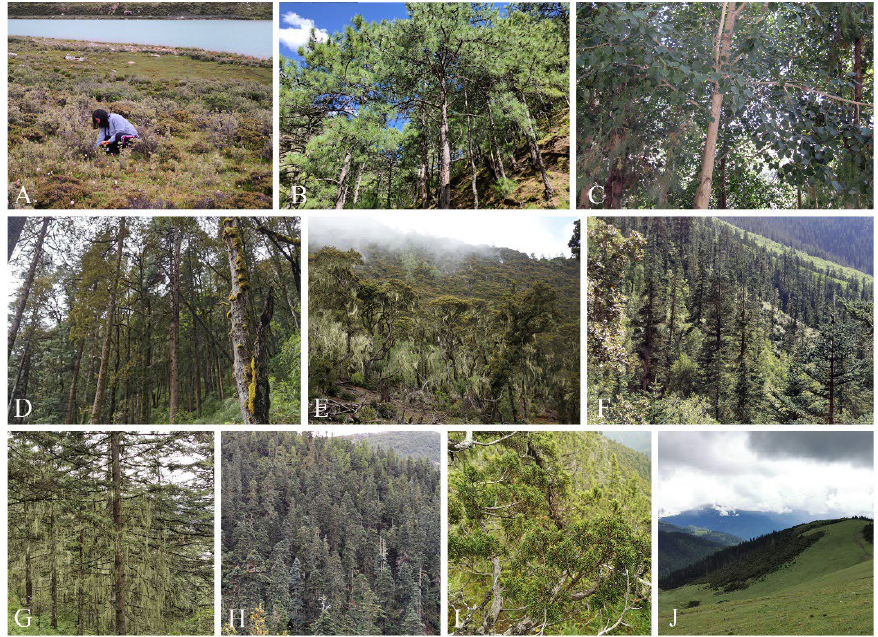
Figure 1. Vegetation types in the Shaluli Mountains. ( A ) SS; ( B ) Pin; ( C ) Pop; ( D ) PQ; ( E ) Que; ( F )